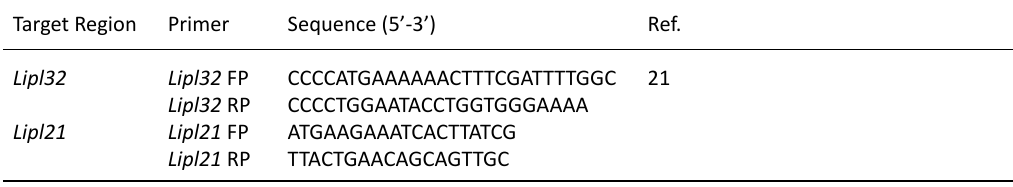
Table 2. List of primers used in this study Target Region Primer Sequence (5’-3’) Ref. Lipl32 Lipl32